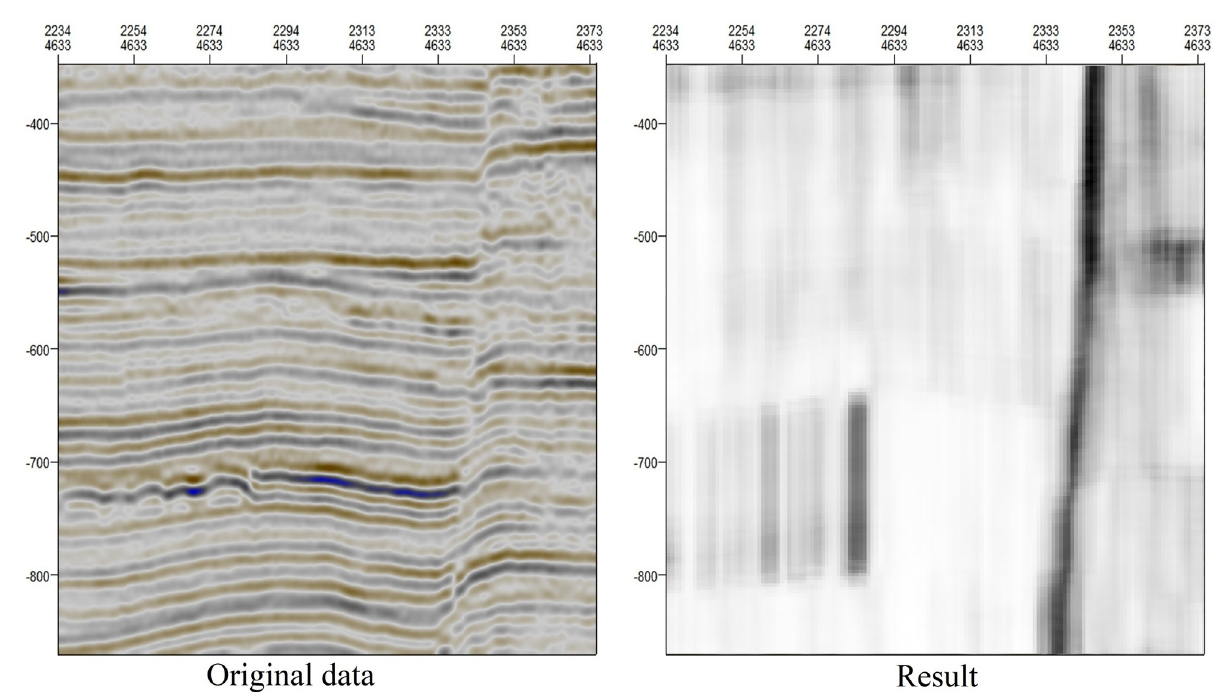
Fig 3. Fault enhancement result extracted based on orientation field